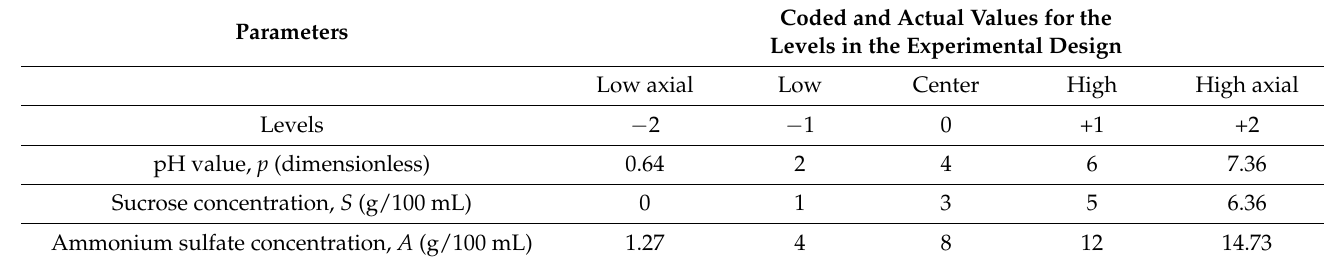
Table 1. Coded and actual levels used in the CCD experimental